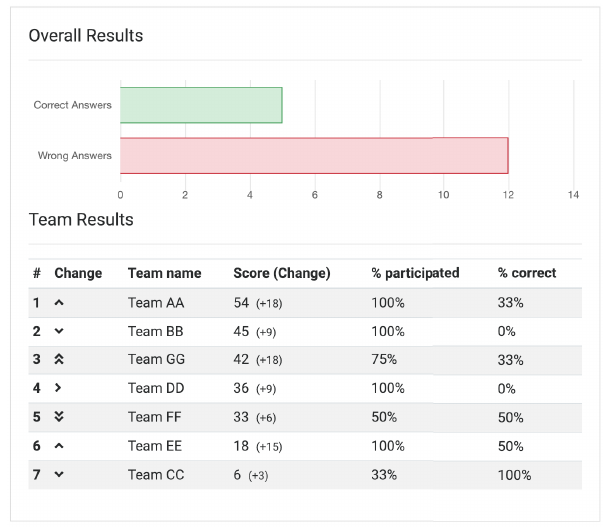
Fig. 2. Classroom (top) and team results (bottom) shown after a quiz has been